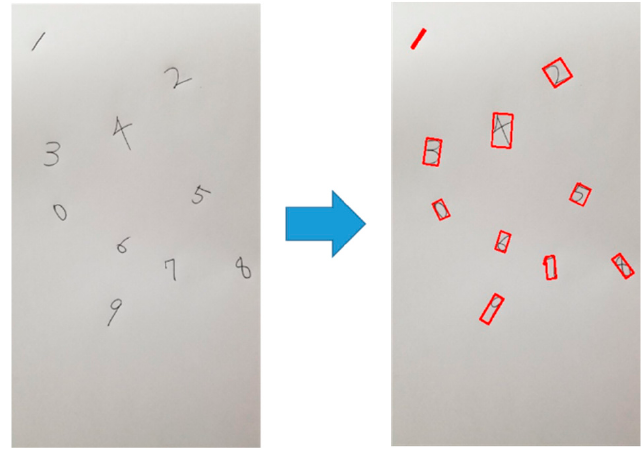
Figure 5. Estimation of the minimum circumscribed rectangle.